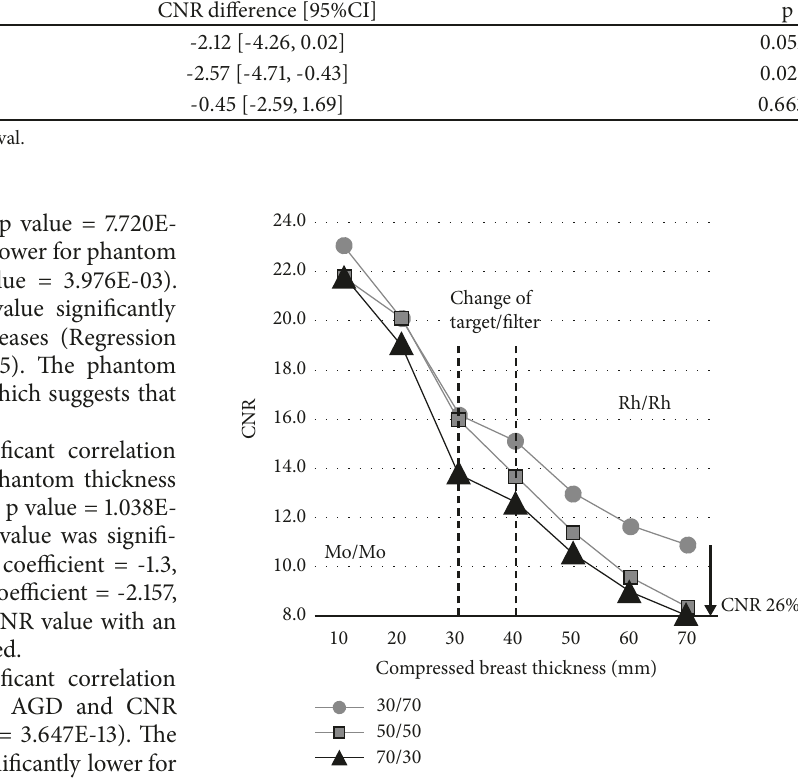
Figure 3: Contrast to noise ratio (CNR) measurement results in breast phantoms with three different tissue ratios plotted against phantom thickness. The CNR was highest in phantom model A (30/70) at all thicknesses. The CNR decreased as the mammary gland density increased, and the thickness of the breast model increased. Mo: molybdenum and Rh: